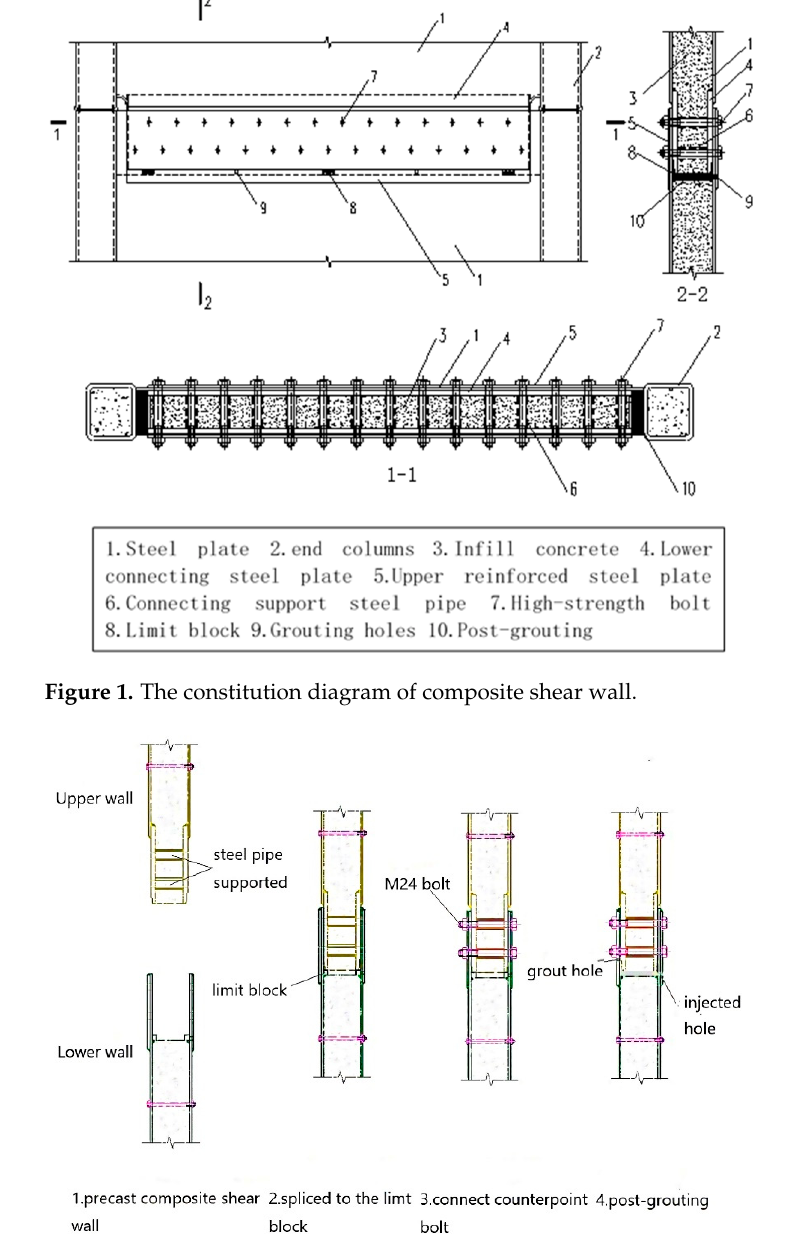
Figure 2. Connection construction method of the upper and lower composite shear